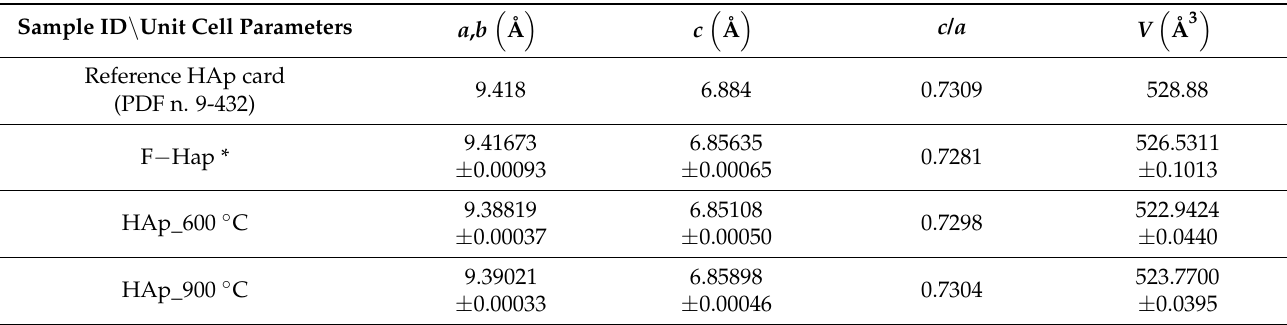
Table 2. Calculated Unit Cell lattice parameters (hexagonal system).